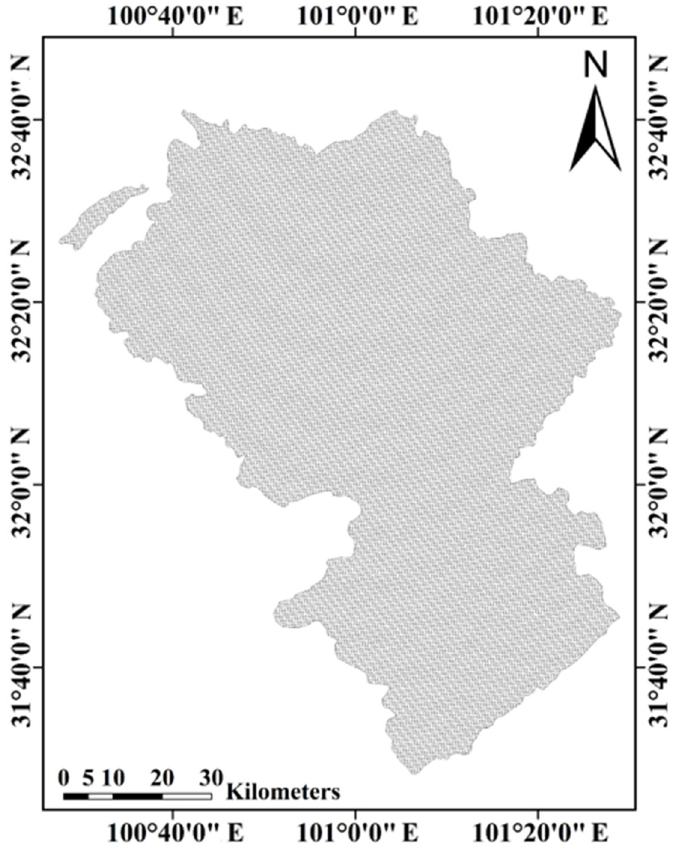
Figure 3. The fishnet of Rangtang County. Table 6. Classification of EI based on ecological